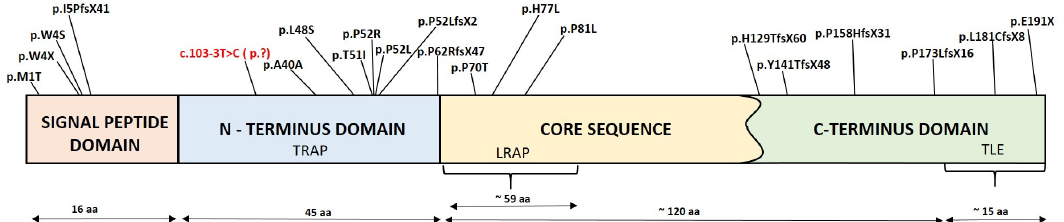
Figure 5. Diagram showing disease-causing variants, named according to the reference sequence NM_182680.1, identified in reported families with the AMELX phenotype. The amelogenin protein has several structural domains shown in coloured boxes (adapted from [75,76]). The bottom line shows the range of amino acids in particular domains (TRAP represents tyrosine-rich amelogenin protein, LRAP leucine-rich amelogenin protein, and TLE telopeptide). The disease-causing variant identified in this study is shown in red. * Disease-causing variants with no product are not labelled